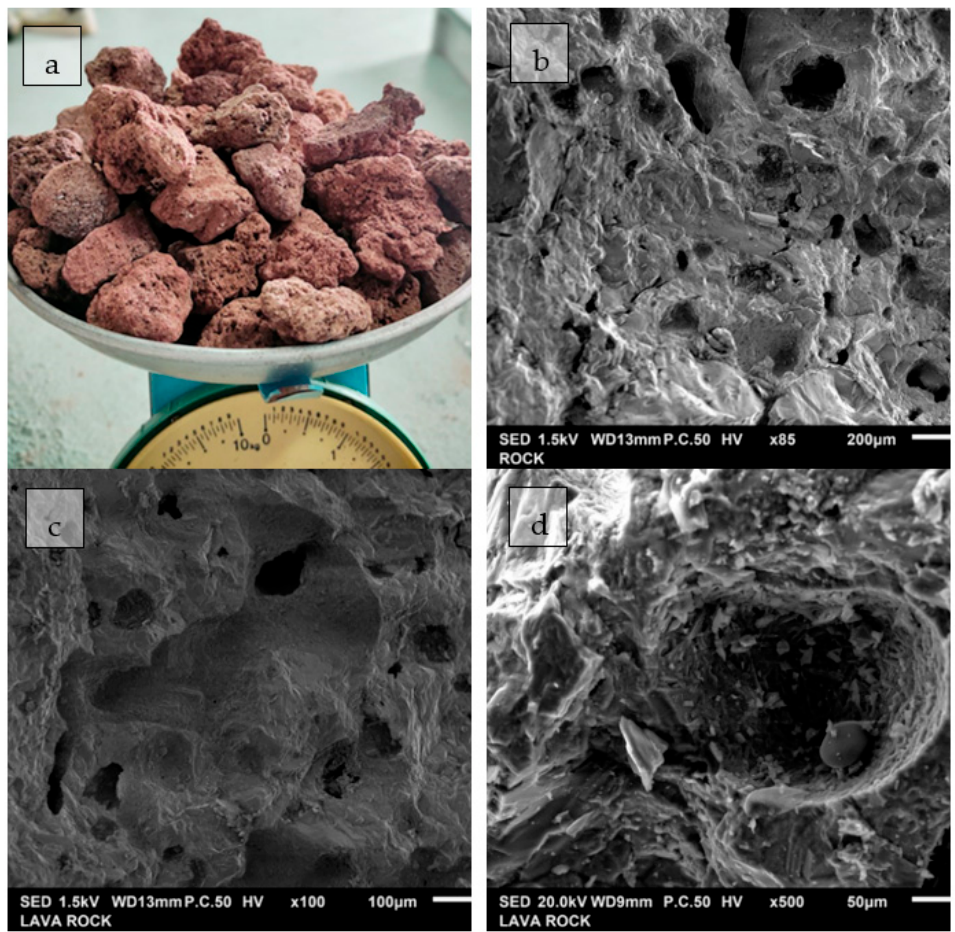
Figure 3. ( a ) Images of lava rock (Scoria type) ready for installation, ( b – d ) Scanning Electron Diffrac- tion (SED) images of the lava rock (Scoria type) under different magnification showing the porosity of the rock.